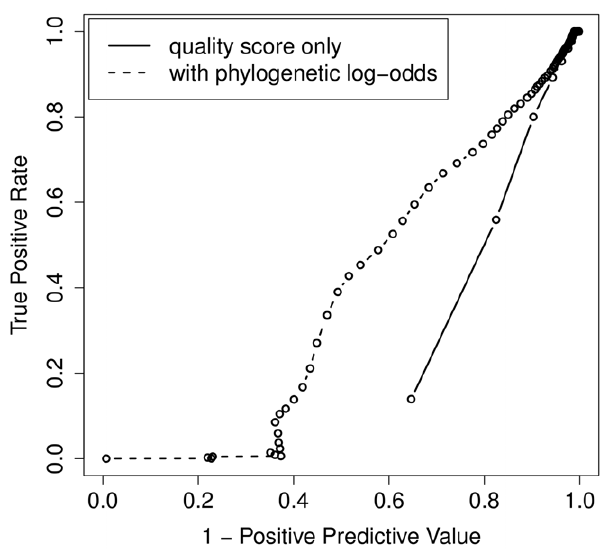
Figure 7. ROC-like plot for logistic regression-based SEM. Results are shown for one species, the bushbaby (see Figure S6 for others). See Figure 6 for comparison. The solid curve represents simple thresholding on quality score and the dashed line represents the use of logistic regression with both quality scores and phylogenetic log-odds scores as covariates (see Materials and Methods).